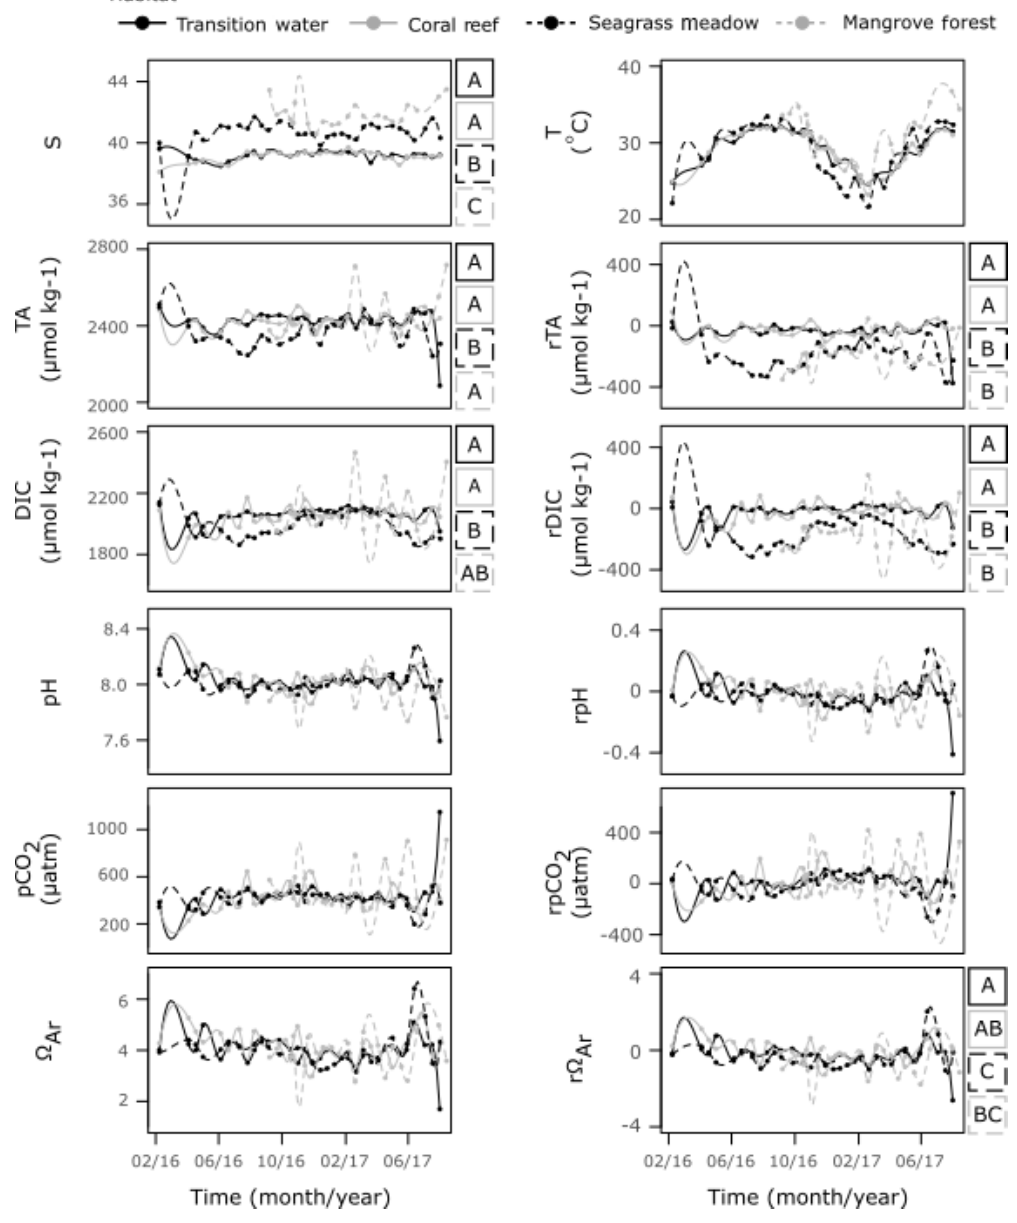
Figure 7. Time series observations of S , T , carbonate parameters and non-conservative carbonate system residuals collected from the four time series stations. Observations are shown fitted with a spline function of the order of 100 by the method of Forsythe et al. (1977). For variables which displayed a significant result for WR-ANOVA tests for differences in medians across habitat groups, results from post hoc bootstrapped t tests are shown as letters (A–C) to the right of the plot. If tests showed significant similarities at the 0.05 significance level with another habitat across a variable, they were assigned the same